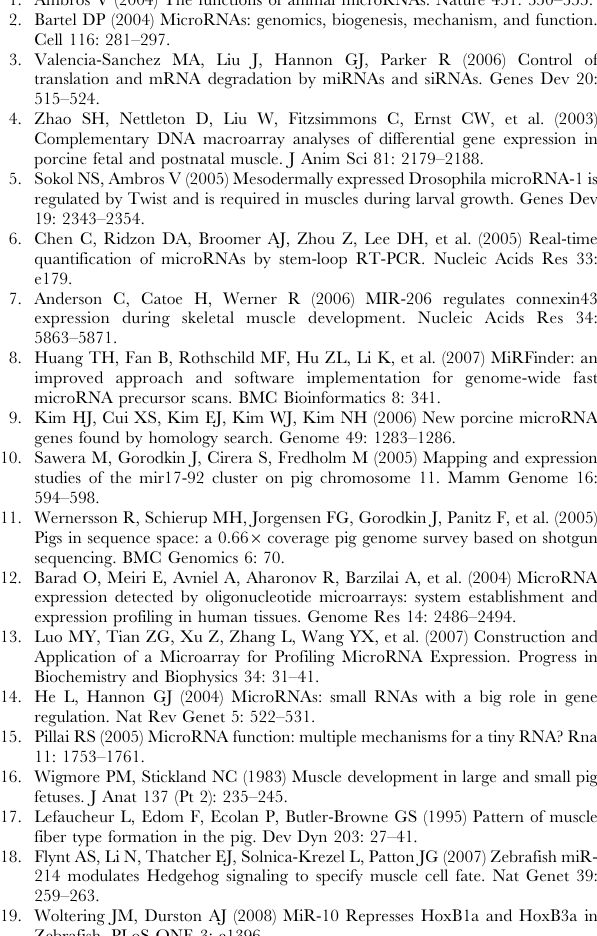
Found at: doi:10.1371/journal.pone.0003225.s004 (0.19 MB XLS) Found at: doi:10.1371/journal.pone.0003225.s005 (0.08 MB XLS) Found at: doi:10.1371/journal.pone.0003225.s006 (0.04 MB XLS) Found at: doi:10.1371/journal.pone.0003225.s007 (0.02 MB XLS) Found at: doi:10.1371/journal.pone.0003225.s008 (1.87 MB XLS)